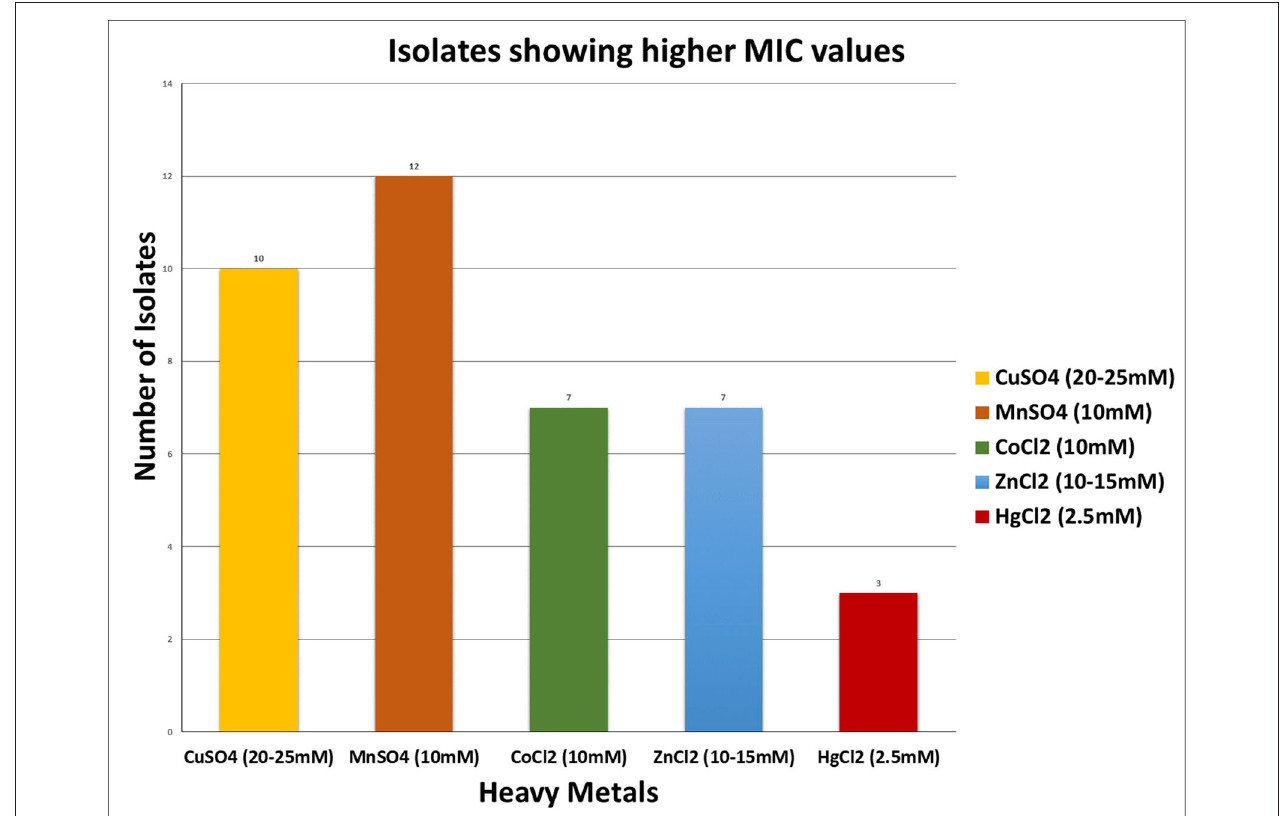
FIGURE 3 | Minimum inhibitory concentration showing by isolates toward various heavy